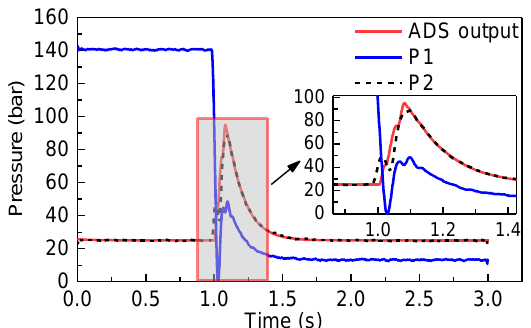
Figure 16. The pressure of cylinder chambers without ADS.